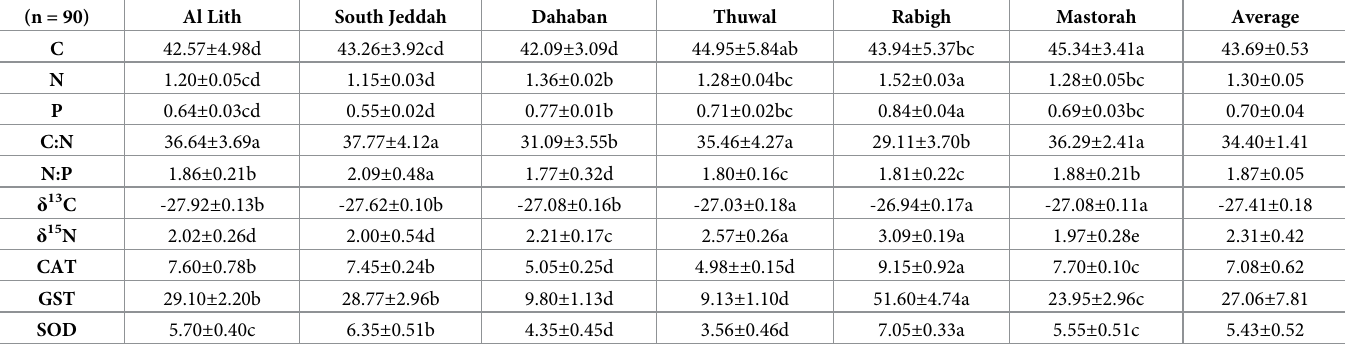
Table 5. Mean ( ± SE) of nutrients concentrations (%) and antioxidants ( μ mol/min/mg protein) in A . marina leaves at 6 sites on the coast of the central Red Sea, Saudi